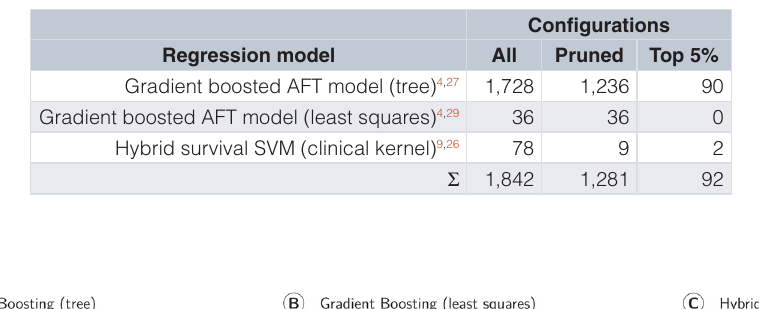
Table 3. Heterogeneous ensemble used in sub challenge 1b of the Prostate Cancer DREAM Challenge. All denotes the initial size of the ensemble, Pruned the size after pruning models with a root mean squared error more than 15% above the error of the best performing model, and Top 5% to the final size of the ensemble corresponding to the top 5% according the combined accuracy and diversity score in Algorithm 2. AFT: Accelerated Failure Time.